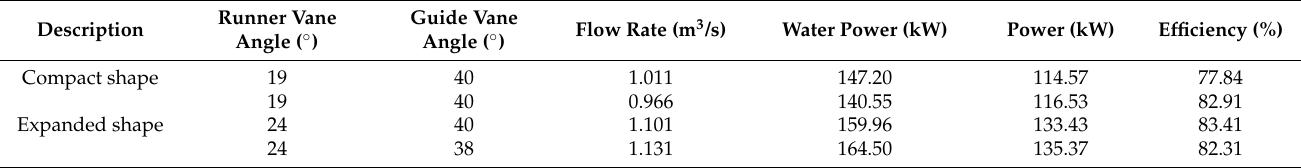
Figure 25. Changing the shape of the runner vane.